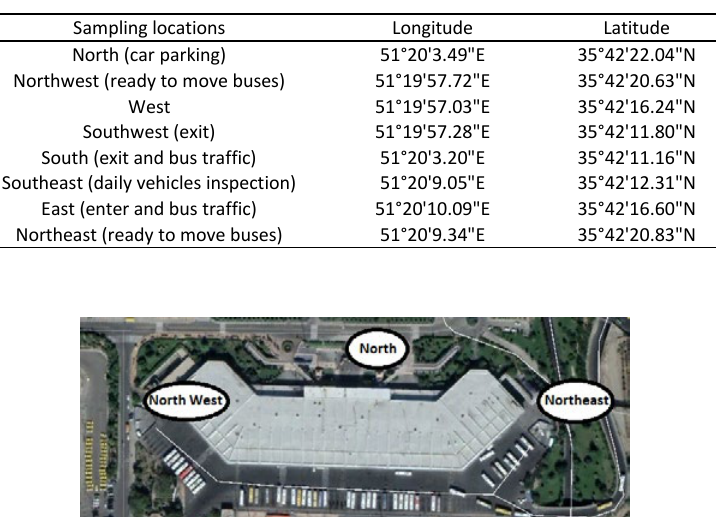
Table 2: Geographical coordinates of the locations selected for air pollutants sampling